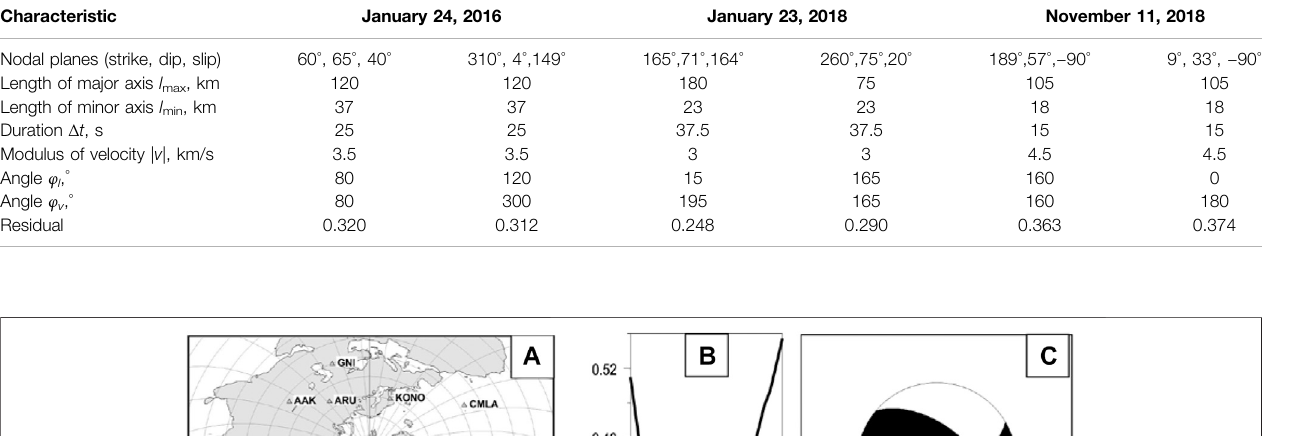
TABLE 2 | Characteristics of the three major earthquake sources in Southern Alaska, 2016 – 2018. The earthquake source parameters are given for each of the two nodal planes. Characteristic